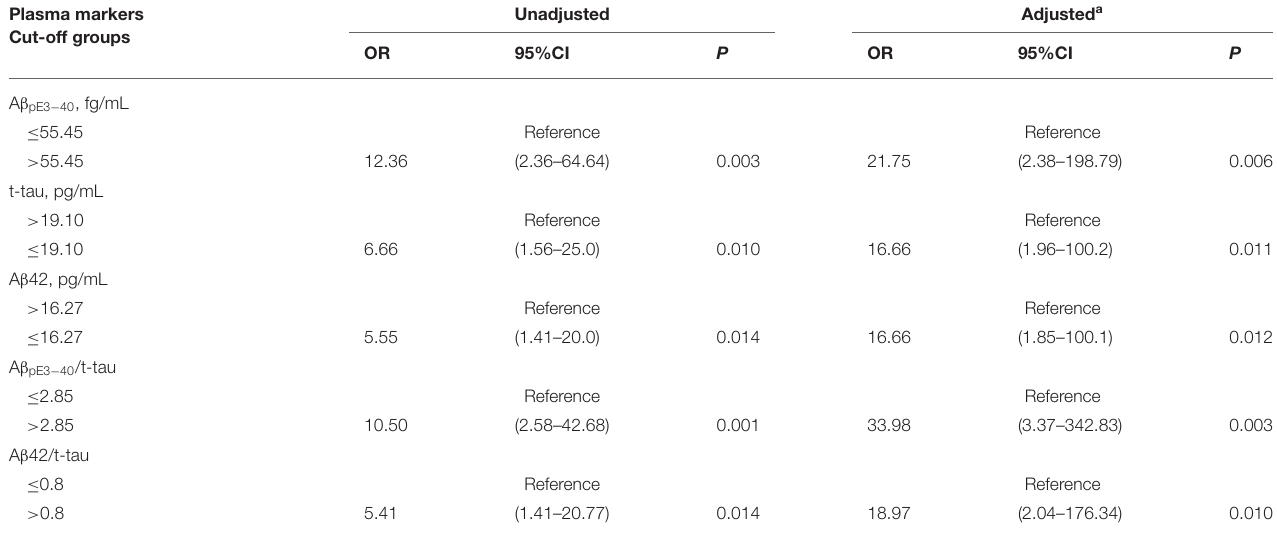
TABLE 4 | Association of plasma biomarkers with A β PET positivity ( N = 46). Plasma markers Cut-off